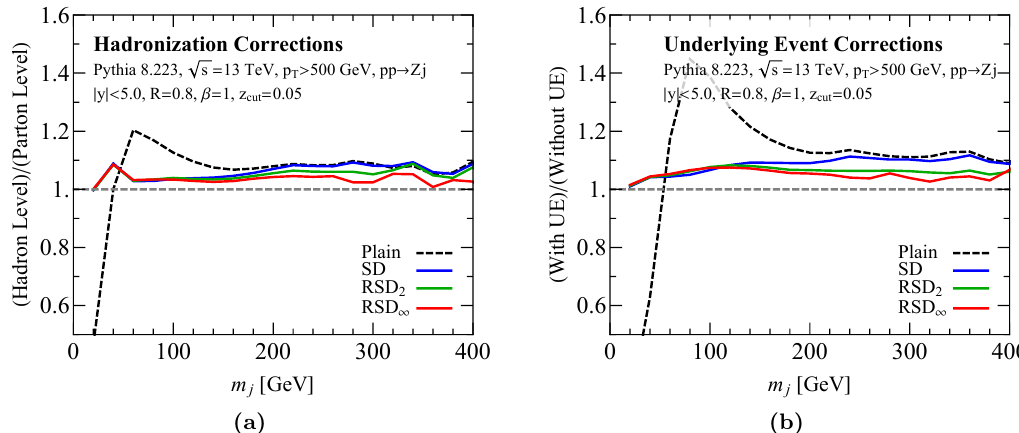
Figure 4. Study of (a) hadronization and (b) underlying event corrections for di(cid:11)erent N values, with (cid:12) = 1 and z cut = 0 : 05. Shown are ratios of the groomed jet mass spectrum as non-perturbative e(cid:11)ects are included in Pythia